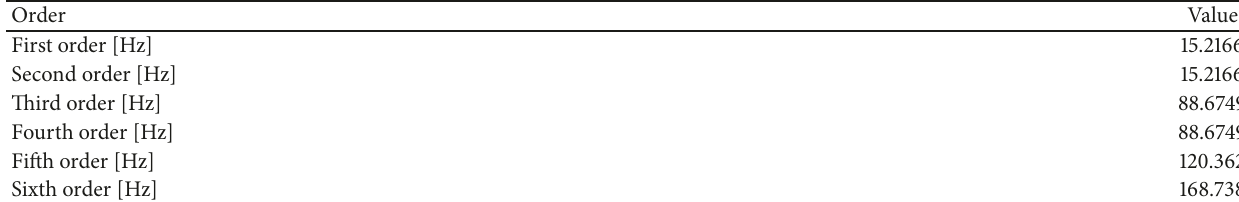
Figure 16: The first six-order mode vibration profile of drag rotor. Table 13: The first six-order mode natural frequency of